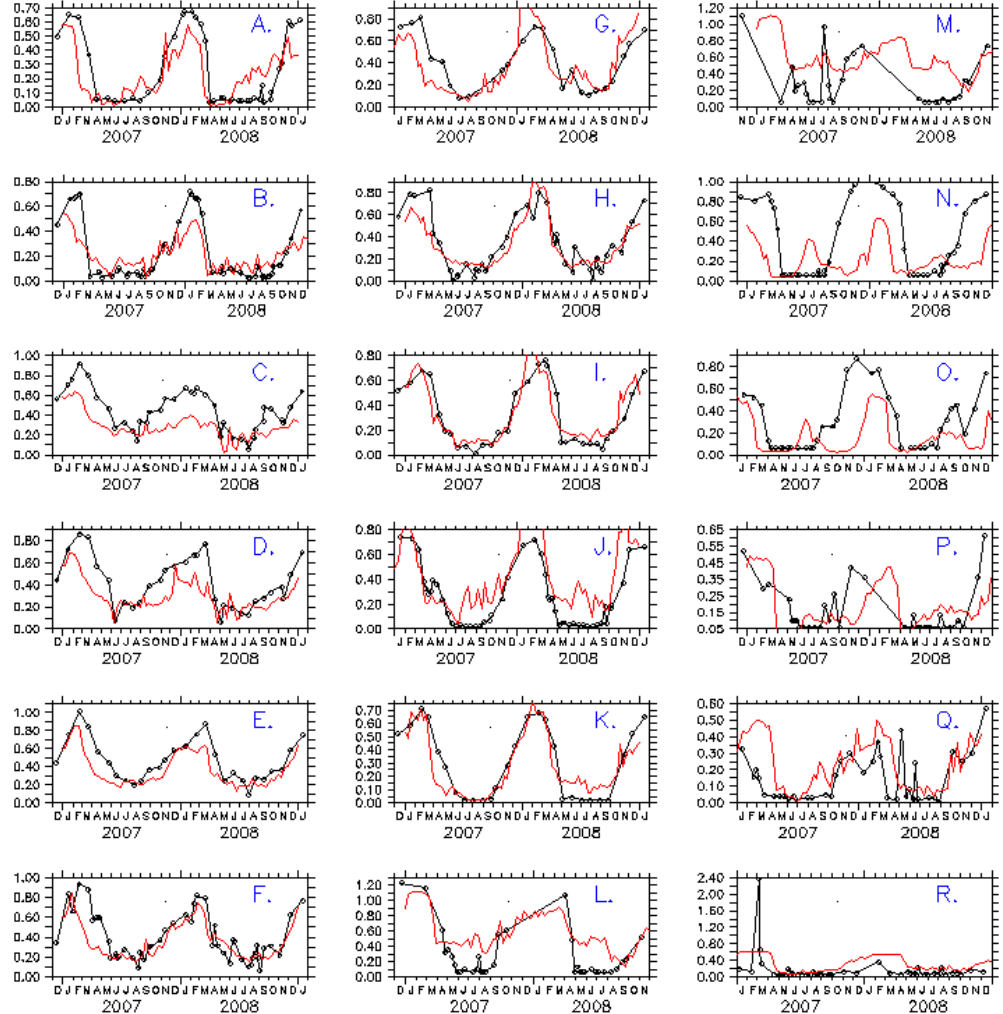
Fig. 8. Seasonal variability of DIP in surface layer. Notations same as in Fig.